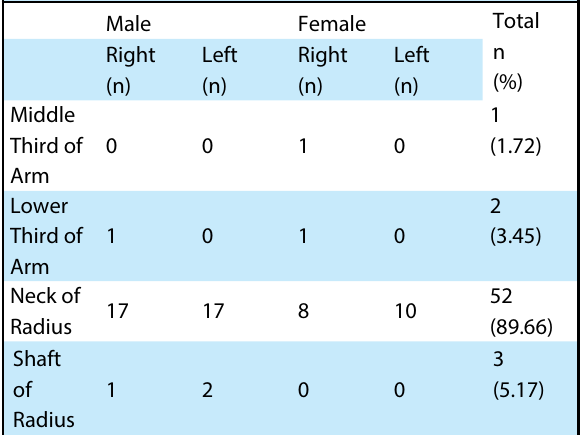
Table 1. Gender-wise frequency of the level of termination of brachial